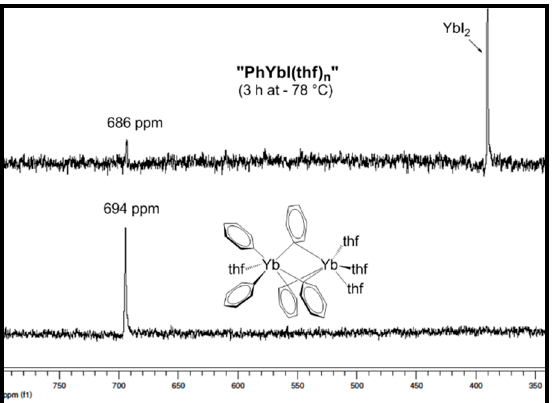
Figure 4. 171 Yb-NMR spectra of “PhYbI(thf) n ” (top, − 78 ◦ C) and complex 3 (bottom, − 30 ◦ C). 2 PhYbI YbPh 2 + YbI 2 Scheme 3. Schlenk equilibrium in the PhYbI system (coordinated solvent not shown) [41].